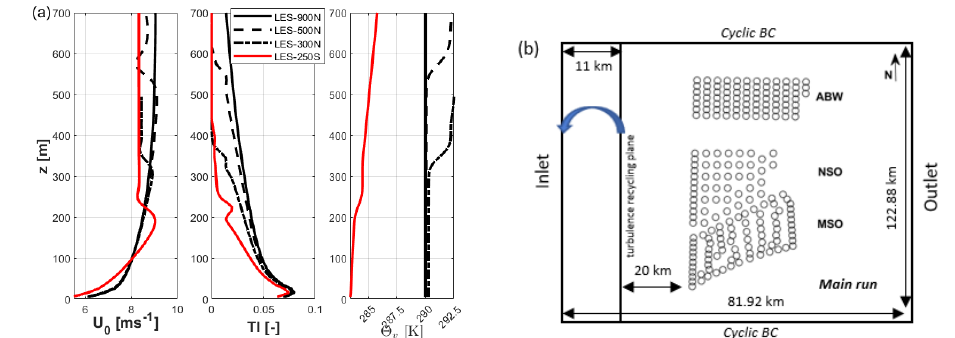
Figure 2. ( a ) Fully developed inflow vertical profiles averaged over the span direction and the last 90 min of the main run at the inflow plane of the main run. Wind speed (left), turbulence intensity (center) and virtual potential temperature (right) for all the cases simulated in this study. ( b ) Simulation domain sketch for the Neutral simulations. In the stable case, the model domain was 102,400 m long and the turbulence recycling plane was at x = 10 km. The first turbines were then located about 40 km further